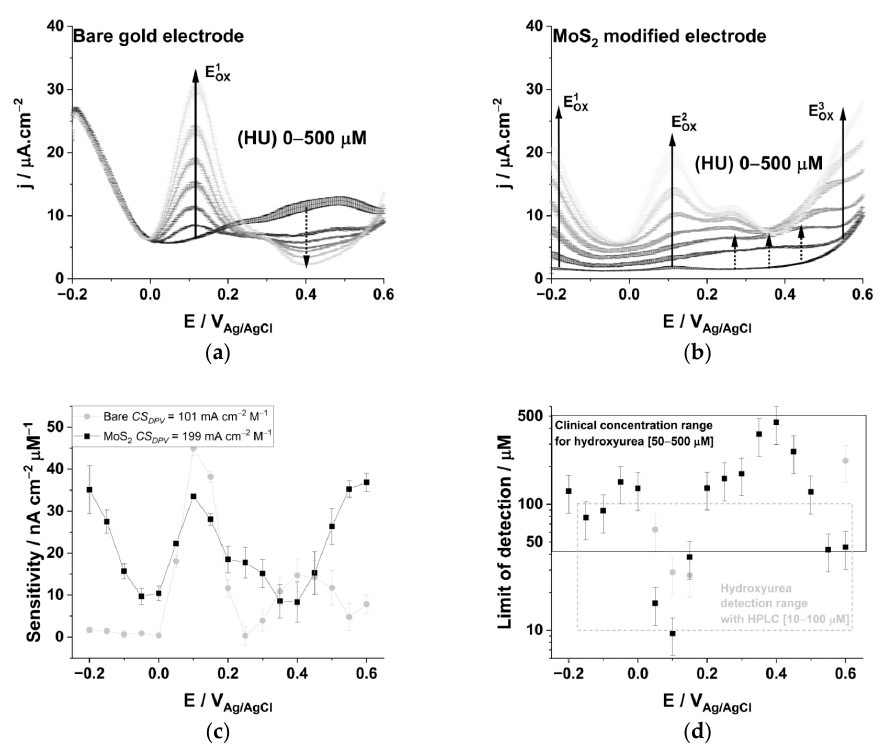
Figure 2. Differential pulse voltammograms at increasing hydroxyurea concentration (HU: 0, 50, 100, 150, 250, 350, and 500 µ M) in a phosphate buffer saline solution pH 7.4 recorded on ( a ) a bare polycrystalline gold electrode and ( b ) the MoS 2 modified gold electrodes. Faradaic (plain black arrow) and capacitive (dotted black arrow) currents synergistically contribute to the dose-response characteristics of the calibration curves. The electrochemical sensor sensitivities at each potential ( c ) is calculated from regression analysis in the concentration range 0–500 µ M. The limit of detection for HU ( d ) at the bare (gray) and the MoS 2 modified electrode (black) are comprised within the biological concentration